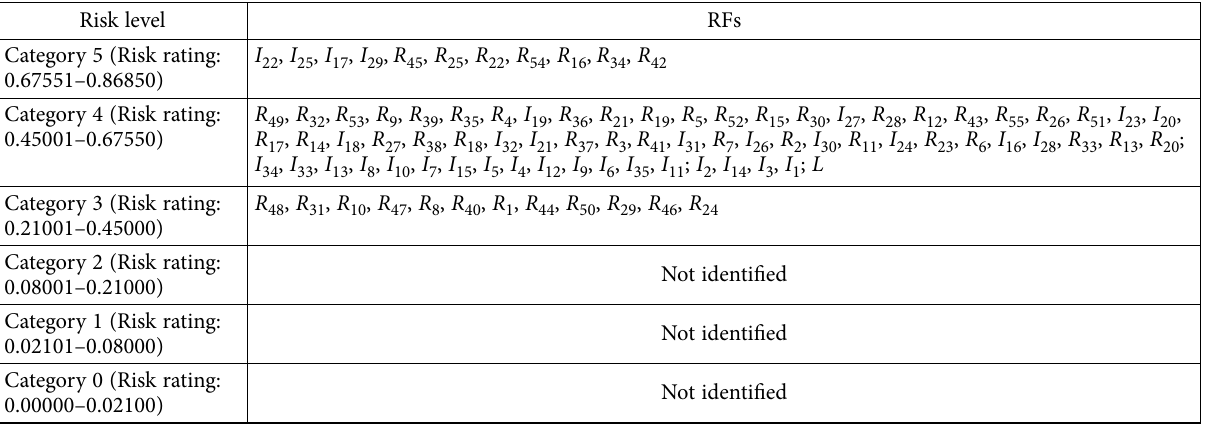
Table 9. Risk categorization for the Ankara-Istanbul high-speed railway project based on FSE method Risk level